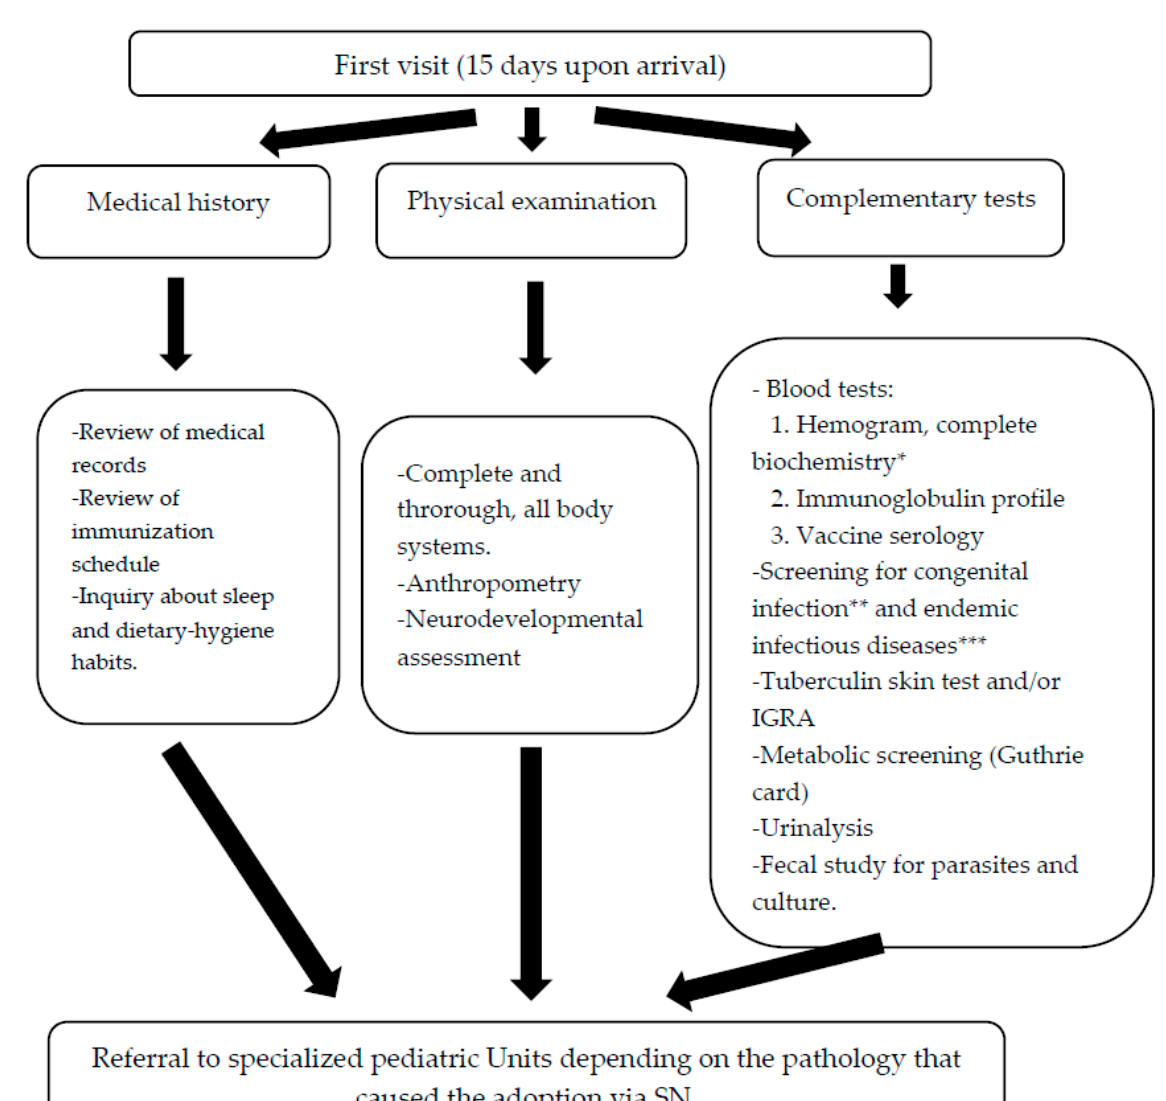
Figure 1. Management protocol for IA children with SN from the International Adoption Unit of the Pediatrics, Infectious and Tropical Diseases Service (Children’s Hospital La Paz—Carlos III). * Basic